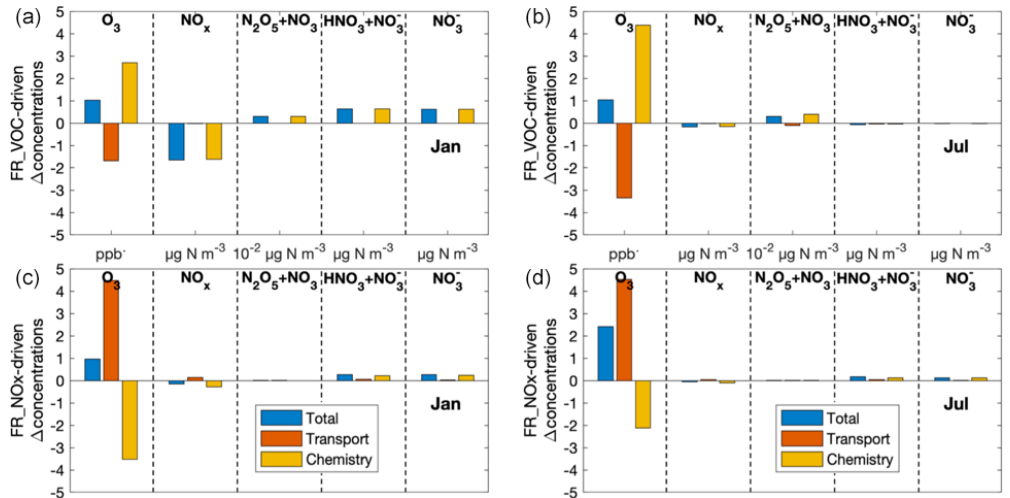
Figure 6. Contributions of foreign anthropogenic emissions of NMVOCs (a, b) and NO x (c, d) to atmospheric oxidizing capacity and oxida- tion products over eastern China as simulated by the GEOS-Chem model for January (a, c) and July (b, d) 2015. Total foreign anthropogenic contributions are split into contributions from direct transport and chemical interactions according to the legend. O 3 concentrations are 24h average concentrations. Nitrogen-related species are presented in micrograms of nitrogen per cubic meter for the convenience of nitrogen budget